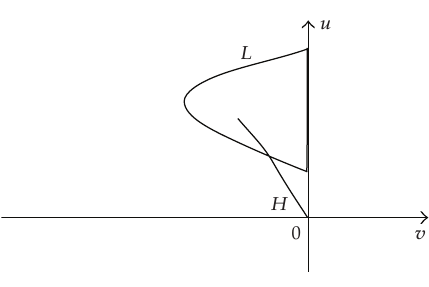
Figure 4: Relative position of L and H in (cid:3) 3 (cid:4)